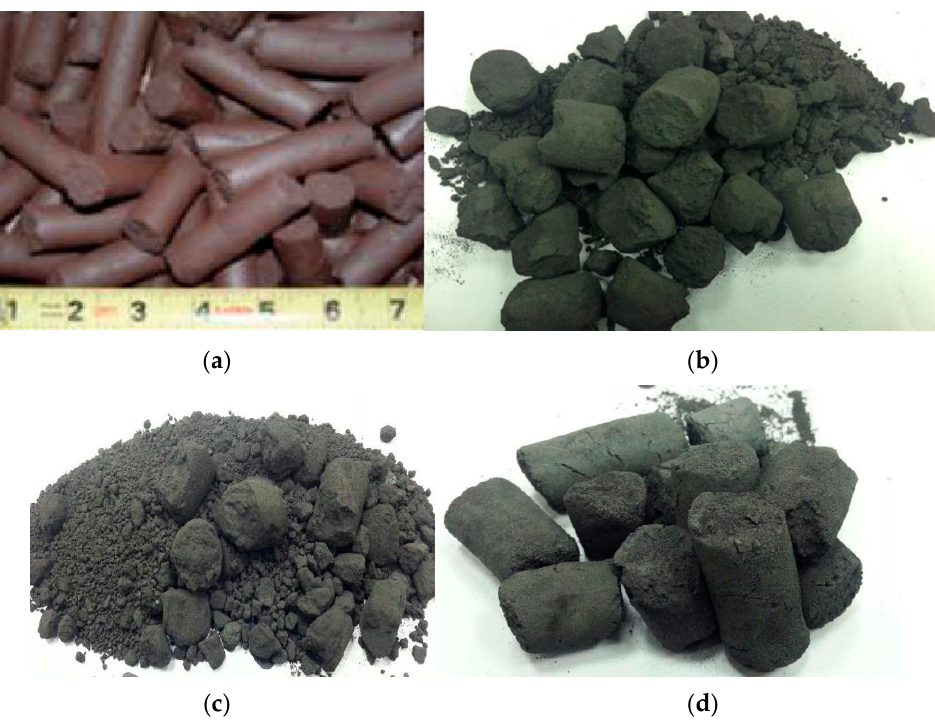
Figure 3. Raw brex ( a ) and reduced brex after extraction from the steel packages ( b ) brex #1, ( c ) brex #2, ( d ) brex #3.